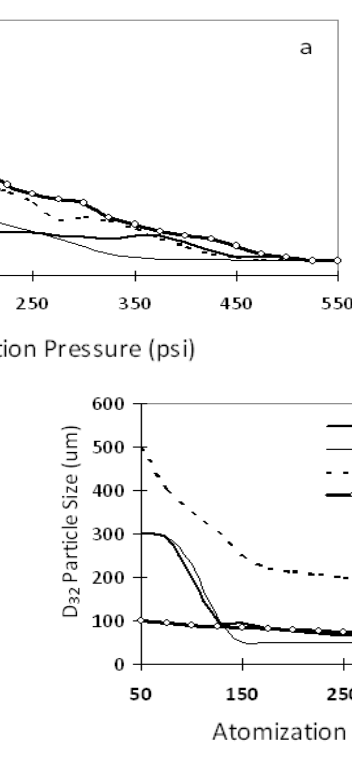
Figure 1. Effect of the type of atomizing gas on the overall D ( b ) He; ( c )